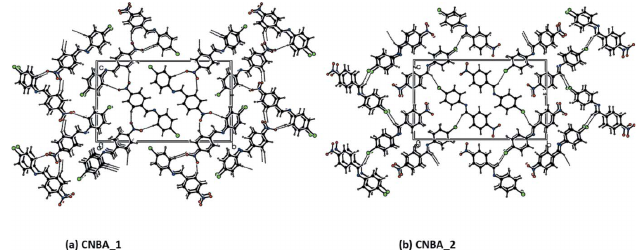
Figure 5 A view along the a axis of the crystal packing of ( a ) the major disorder component and ( b ) the minor component. The hydrogen bonds (see Table 1) are shown as dashed lines.